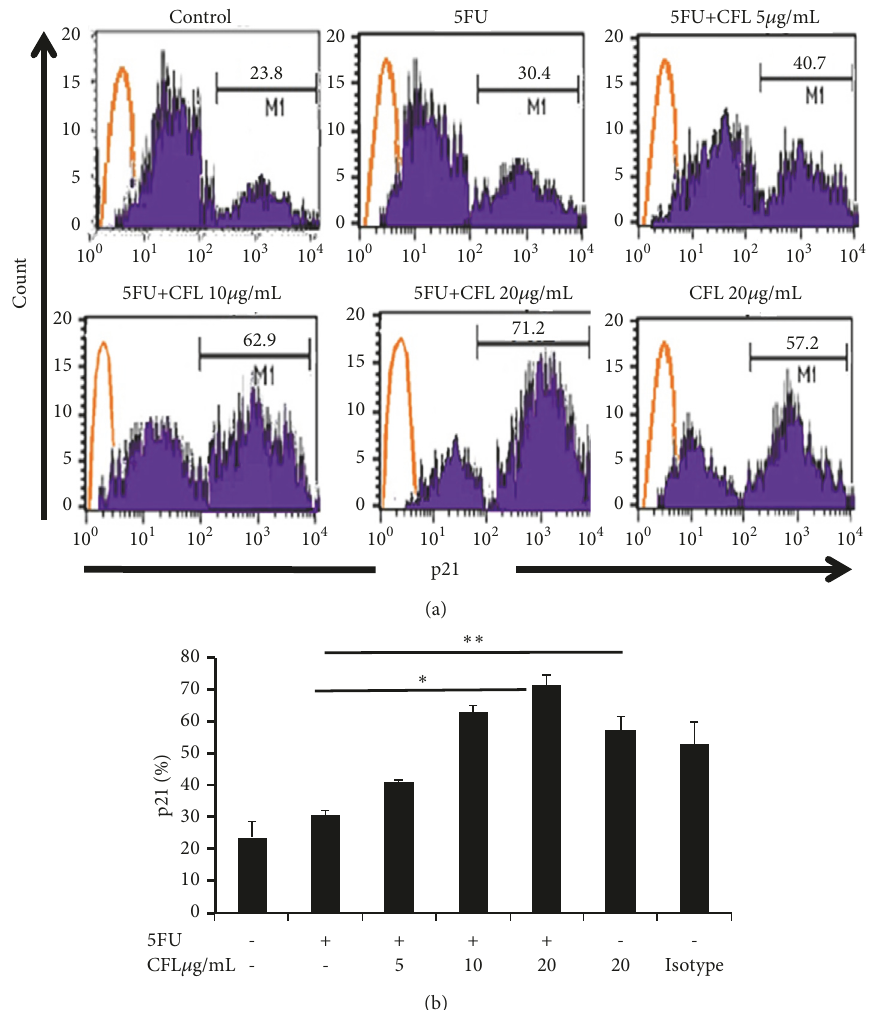
Figure 4: CFL combined with 5-FUreduced p21 expressions of HT-29 . The expression of p21 was assessed to evaluatethe antimetastaticeffect of CFL combined with 5-FU. (a) The percentage of p21 positive cells was analyzed using a FACS Calibur flow cytometer (BD Biosciences). Numbers represent the percentages of p21 positive cells were shown, orange lines (isotype control IgG2b). Results are representative of four independent experiments. (b) The percentage of p21 positive cells was shown inside the panels. Results shown are mean+SD, with n=4 replicates in each group. ∗ p-value < 0.05; ∗∗ p-value p <